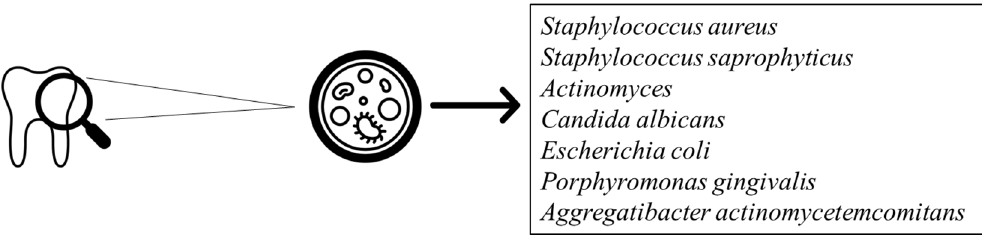
Figure 2. Bacterial strains involved in periodontal disease.